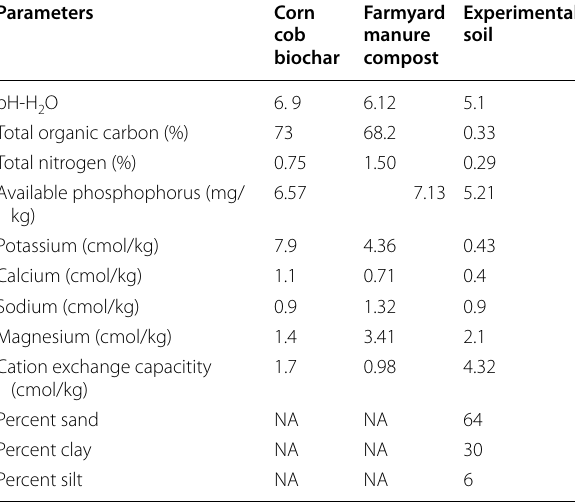
Table 1 Physico-chemical properties of the field soil, corn cob biochar and farmyard compost used in the previous